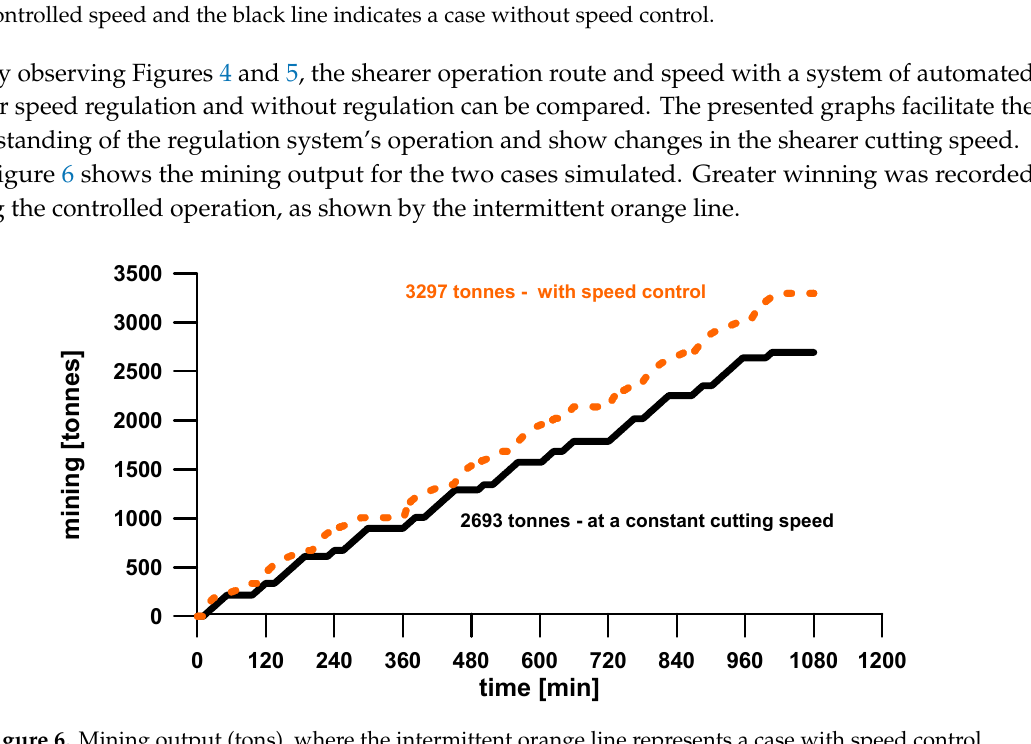
Figure 6. Mining output (tons), where the intermittent orange line represents a case with speed control (3062 (tons)) and the black line indicates a case without speed control (2683 (tons)).